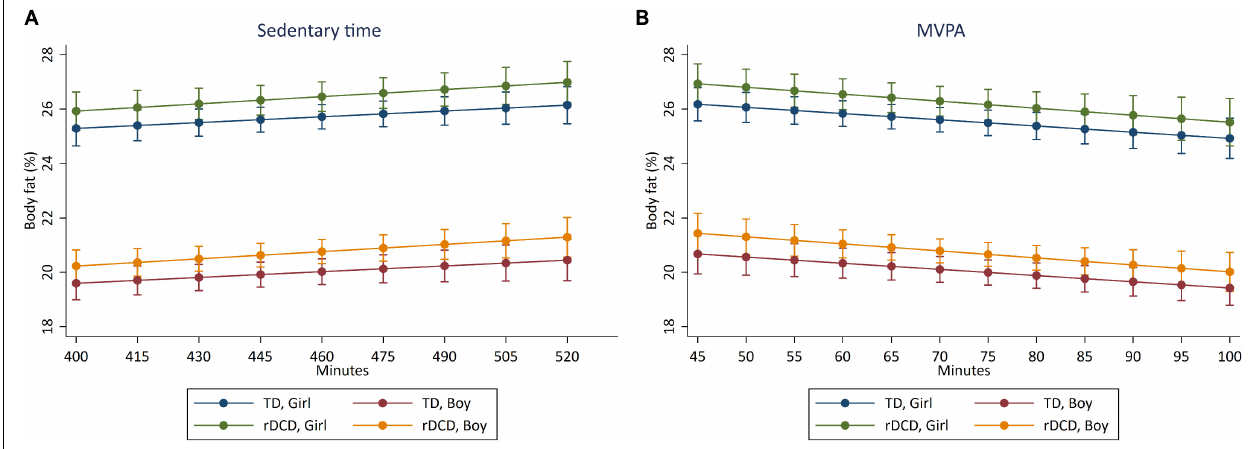
FIGURE 2 | Predictive margins for reductions in body adiposity (%) with increments in (A) sedentary time (min/day) and (B) MVPA (min/day). Cross-sectional association between sedentary time (A) and MVPA (B) with body adiposity in boys and girls classified as TD and rDCD. The highest values on the x -axes represent the 95th percentile of sedentary (A) and MVPA (B)